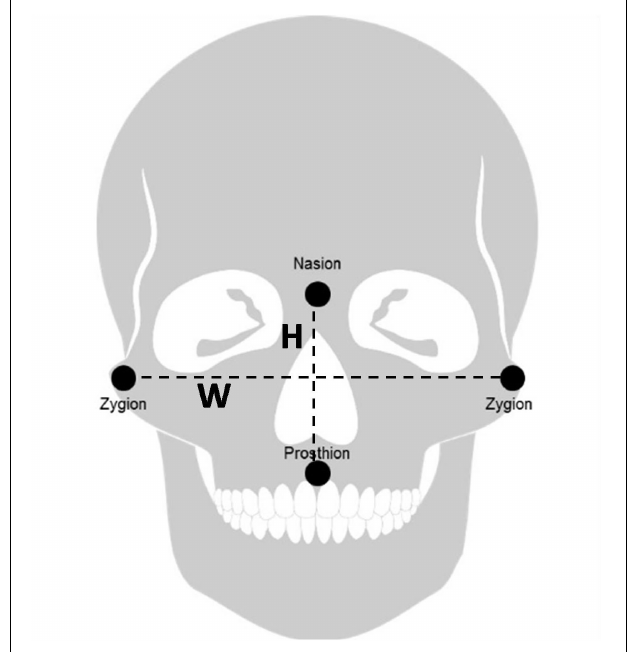
FIGURE 1 | Facial width (W) versus facial height